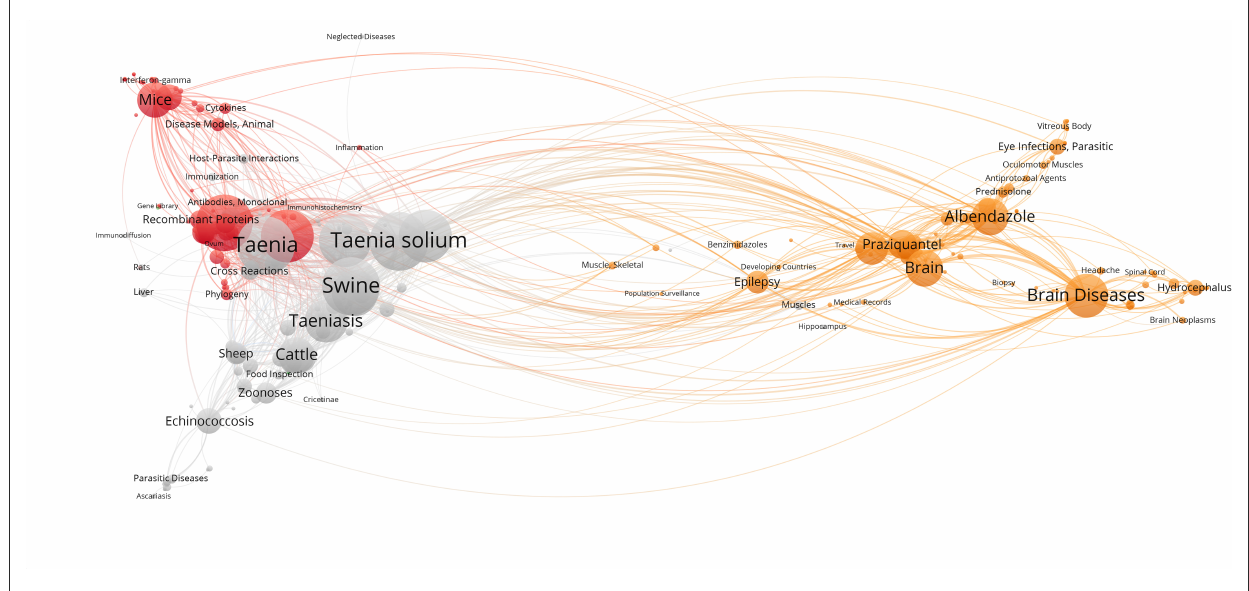
FIGURE3 Thematic clusters generated from the MeSH descriptors assigned to the documents published on cysticercosis and neurocysticercosis and indexed in